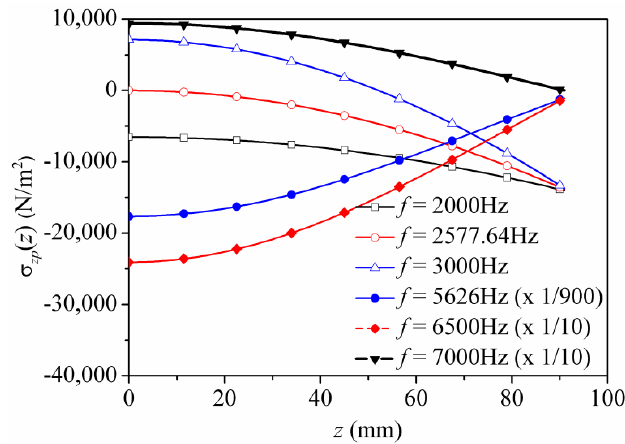
Figure 5. Influence of the voltage frequency on the distribution of stress σ zP ( z ) along the axial direction with V 0 = 2 V .